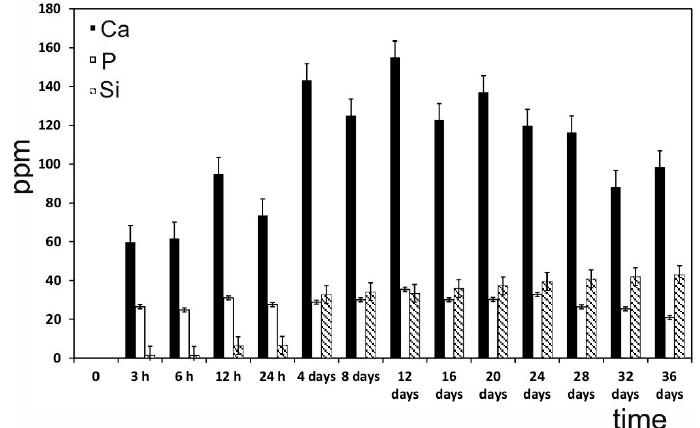
Figure 8. The Si 4+ , Ca ++ , HPO 4= concentrations in the ahMSC culture medium after different immersion times.